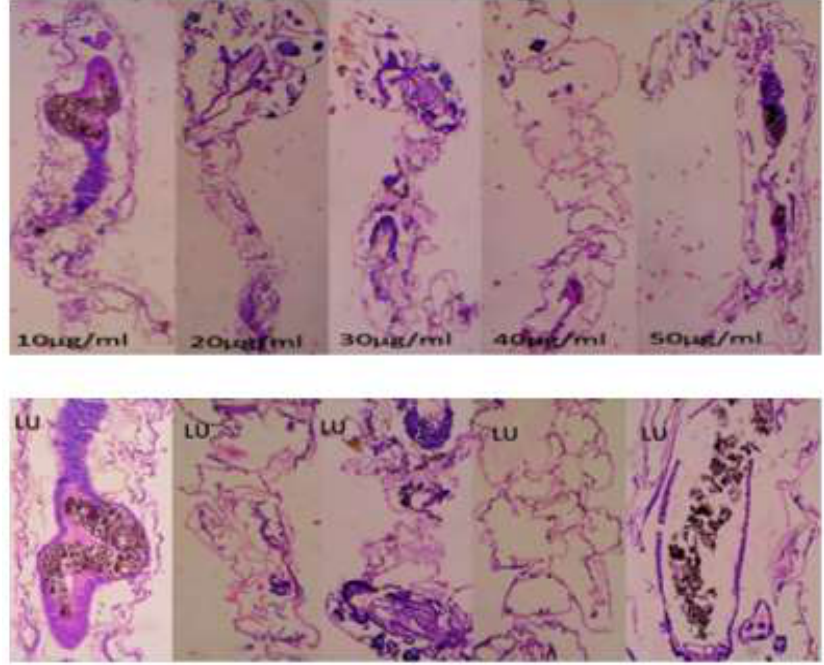
Figure 9. Longitudinal section and midgut lumen of an Aedes aegypti larva exposed to a concentration